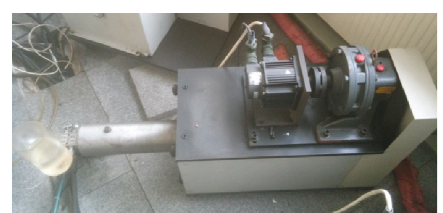
Figure 3: Hydraulic (water) pressure loading